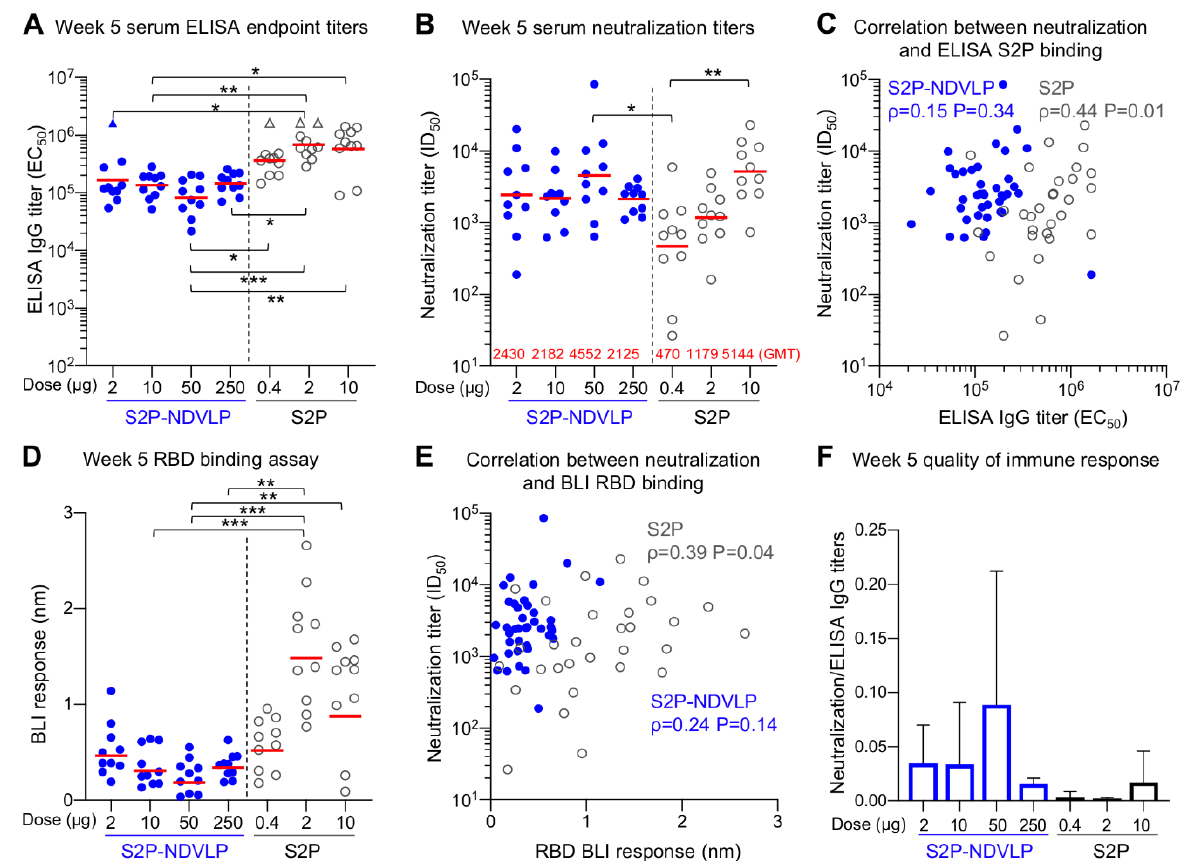
groups, and P-values were designated as *: p < 0.05; **: p < 0.01; ***: p < 0.001; ****: p < 0.0001. Geometric means were indicated with a red bar. Spearman correlation was used in ( D , F ).